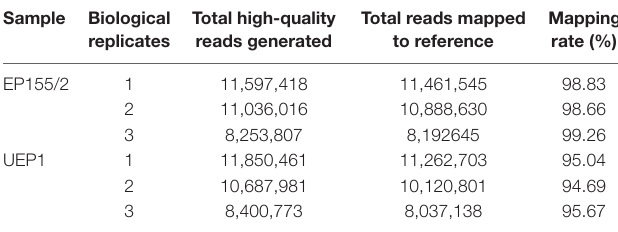
TABLE 1 | Descriptive statistics of sequencing